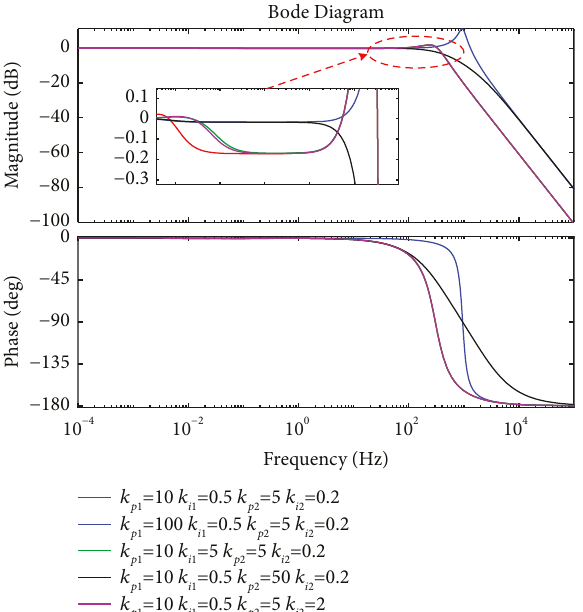
Figure 12: Comparison of amplitude phase frequency characteristics of bidirectional DC-DC double closed-loop control